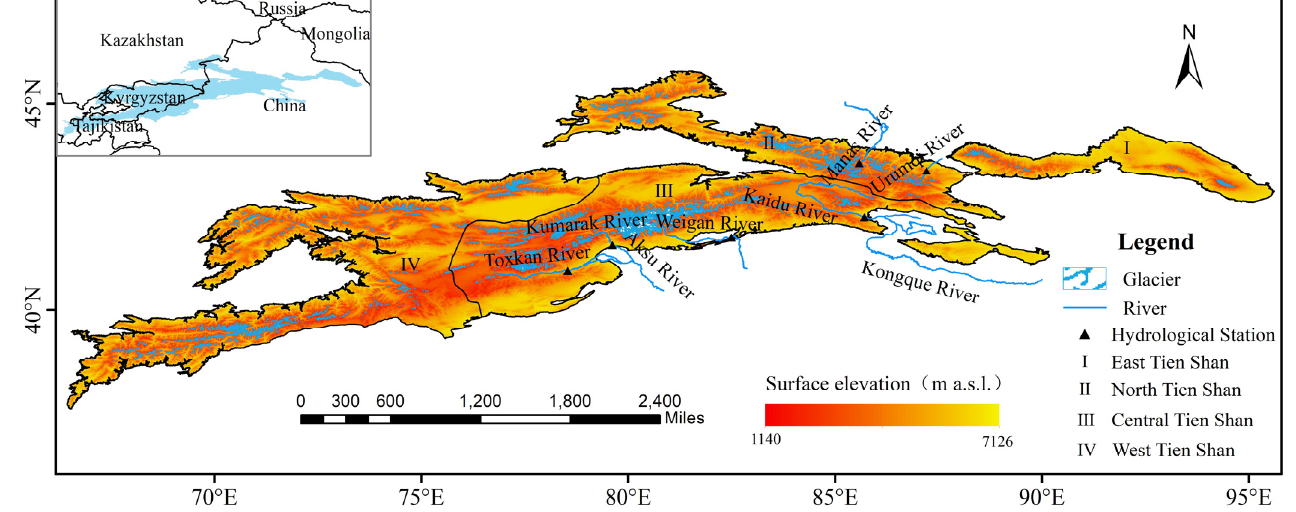
Figure 1. Geographical location map of the Tien Shan Mountains in Central Asia. The inset shows the location of the Tien Shan Mountains. The glacier outlines are from RGI (6.0) and the elevation was based on The Shuttle Radar Topography Mission (SRTM).